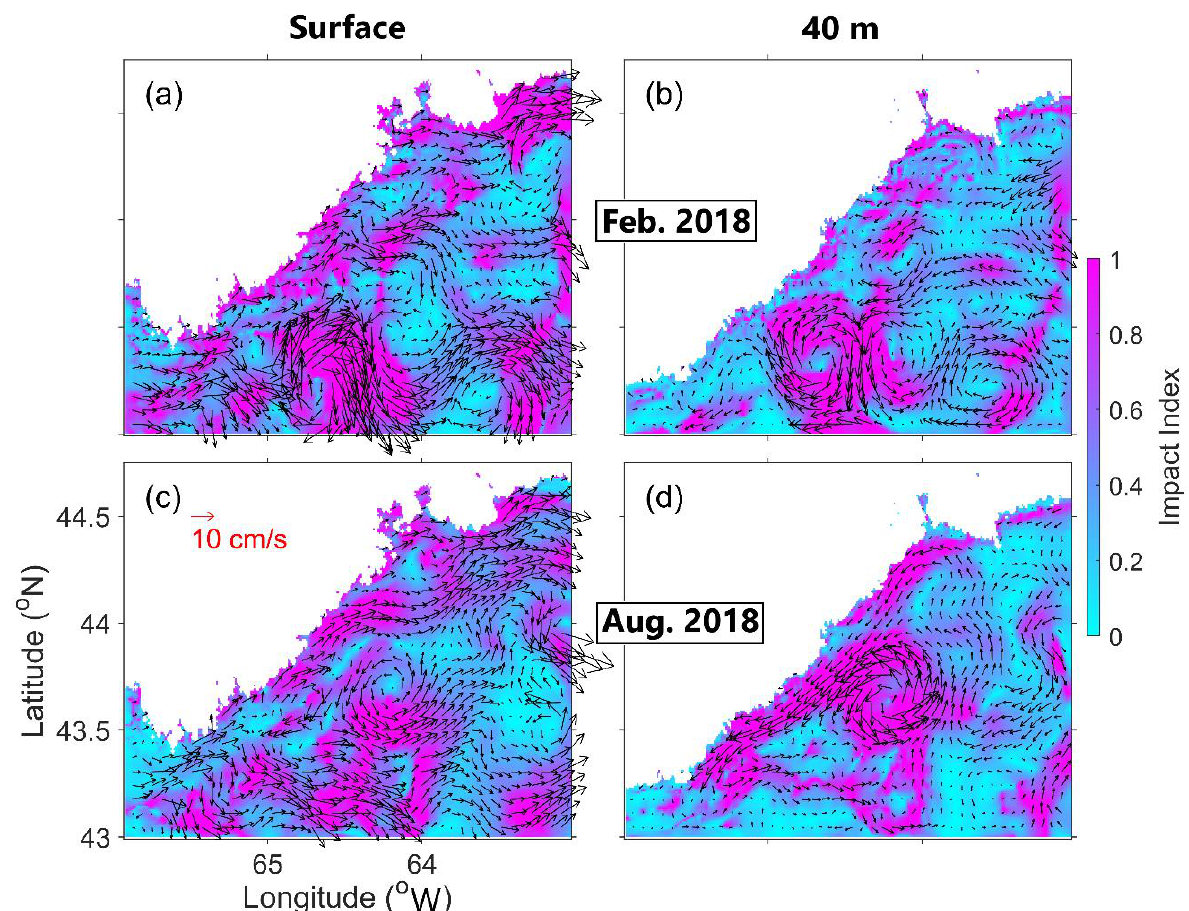
Figure 14. Differences in the monthly-mean ( a , c ) surface and ( b , d ) sub-surface (40 m) currents (vector fields) in ( a , b ) February and ( c , d ) August 2018 between cases CR and NW (calculated based on the L3 model results). For clarity, velocity vectors are plotted at every 7th model grid point. The color image indicates the associated impact index calculated using the method by Wang et al. [9].